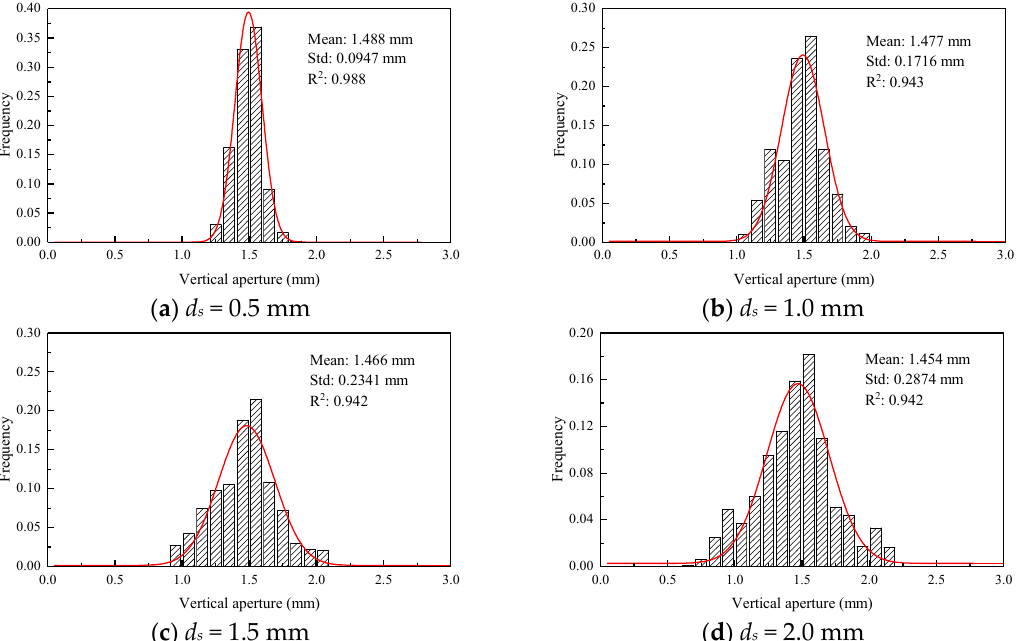
Figure 3. Gaussian distribution and vertical apertures for different shear displacements when JRC = 5.34.